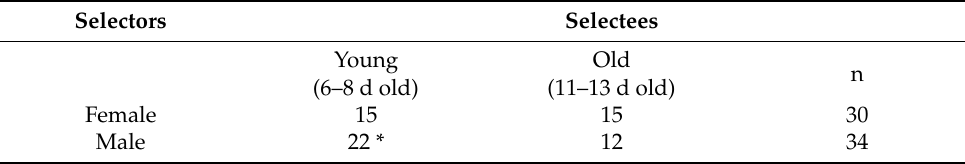
Table 3. Influence of age at mating on A. curvicauda on mate selection. Selectors Selectees Young Old (6–8 d old)